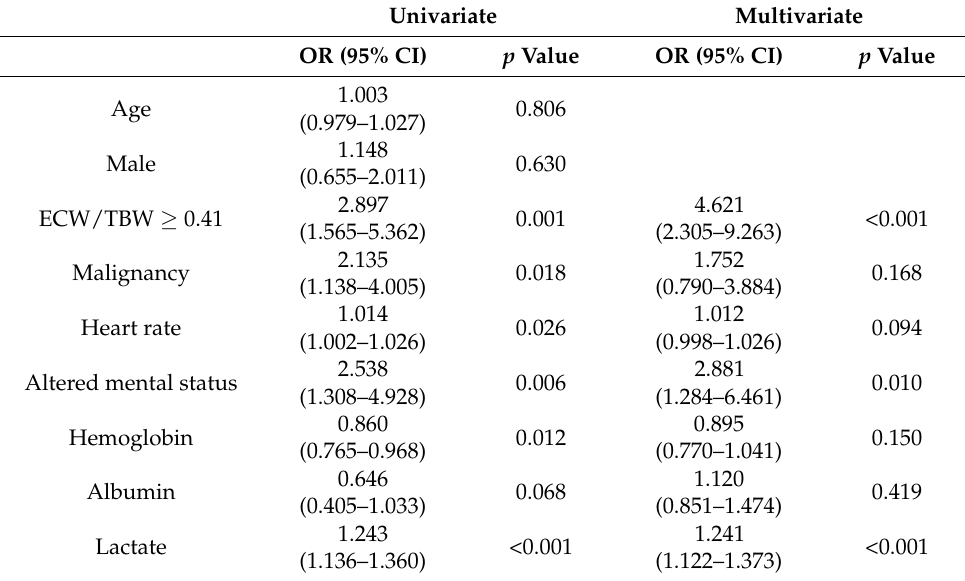
Table 4. Univariate and multivariate logistic regression analysis for the association of mortality in septic